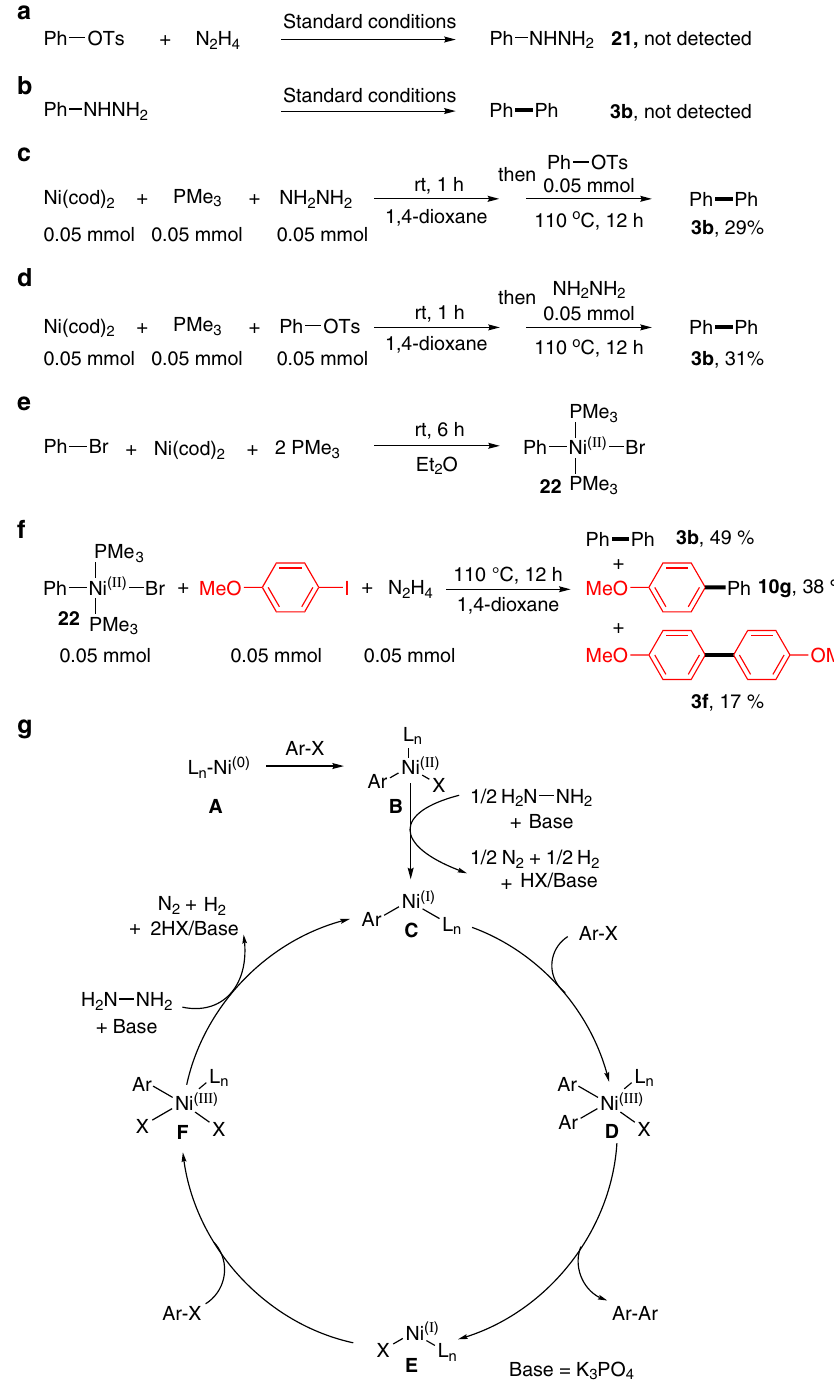
Fig. 9 Mechanistic studies. a Reaction of phenyl tosylate with hydrazine did not give phenyl hydrazine; b reaction of phenyl hydrazine under the standard conditions did not give the biphenyl product; c preparation of trans -[Ni(II)PhBr(Me 3 P) 2 ] complex; d stoichiometric reaction of nickel complex with an aryl iodide in the presence of hydrazine; e pre-mix equimolar Ni(cod) 2 /Me 3 P/hydrazine in dioxane for 1 h, then add the phenyl tosylate; f Pre-mix equimolar Ni (cod) 2 /Me 3 P/ phenyl tosylate in dioxane for 1 h, then add the hydrazine; g proposed pathway for the coupling of aryl electrophiles with N 2 H 4 as